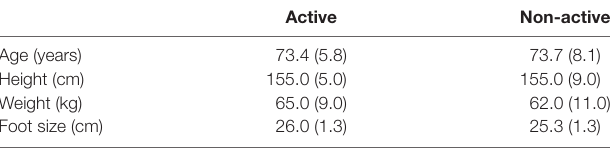
TABLE 1 | Medians and interquartile ranges (IQR) of the age and the anthropometrical data for the active and non-active groups.